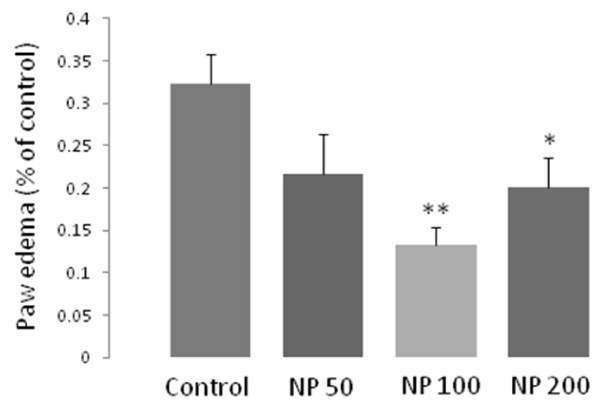
Anti-inflammatory effects of different doses of the essential oil of Nepeta pogonosperma (NP) in formalin-induced paw edema model. Each bar represents for mean ± S.E.M., n = 6 (experimental) - 9 (control) rats, * = p <0.05, ** = p <0.01, compared to control.